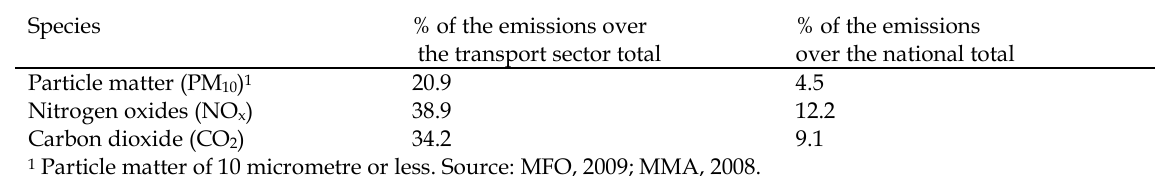
Table 1. Contribution of HDVs to the Spanish atmospheric emissions (2007) Species % of the emissions over the transport sector